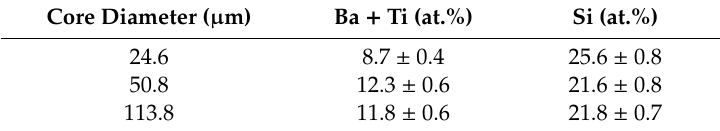
Figure 3. EDX line-scan across the fiber core with core diameter of ( a ) 24.6 µ m and ( b ) 50.8 µ m. Table 1. Average elemental concentration inside core with different core sizes.